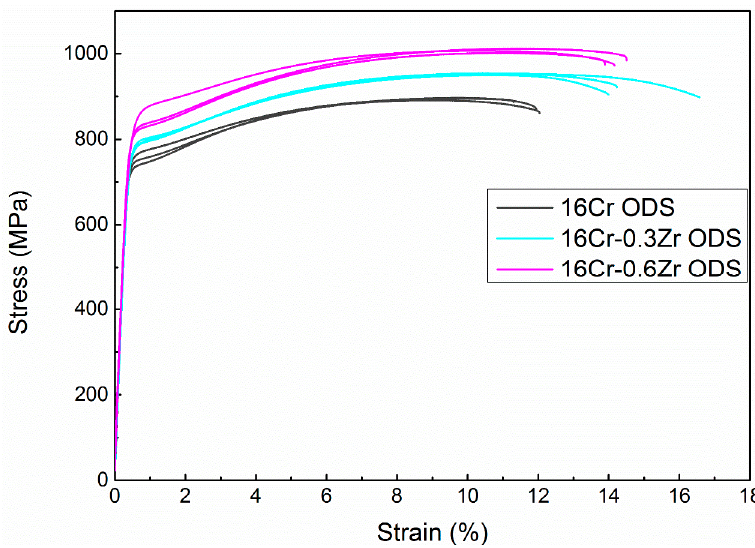
Figure 9. Strain–stress curves of 16Cr ODS, 16Cr-0.3Zr and 16Cr-0.6Zr ODS steels at room temperature.